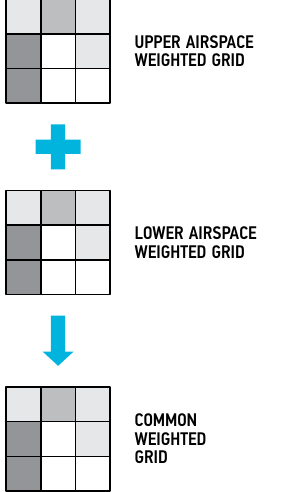
Fig. 9. The generation process of a common grid